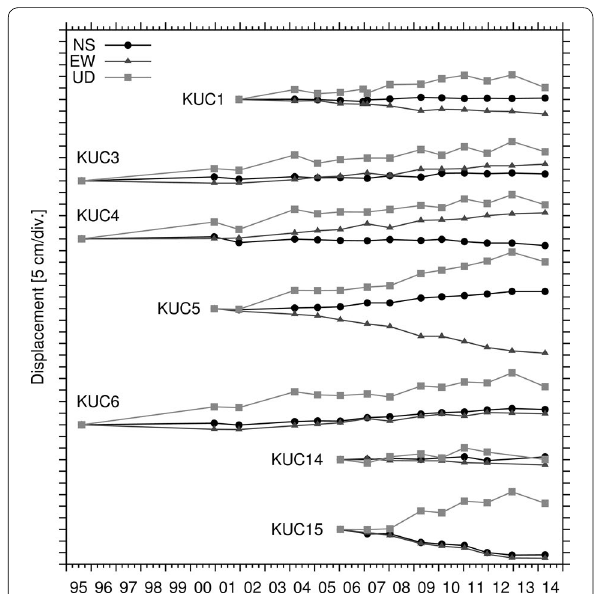
Fig. 3 Temporal change of in relative displacement of benchmarks with respect to KUCG during 1995–2014